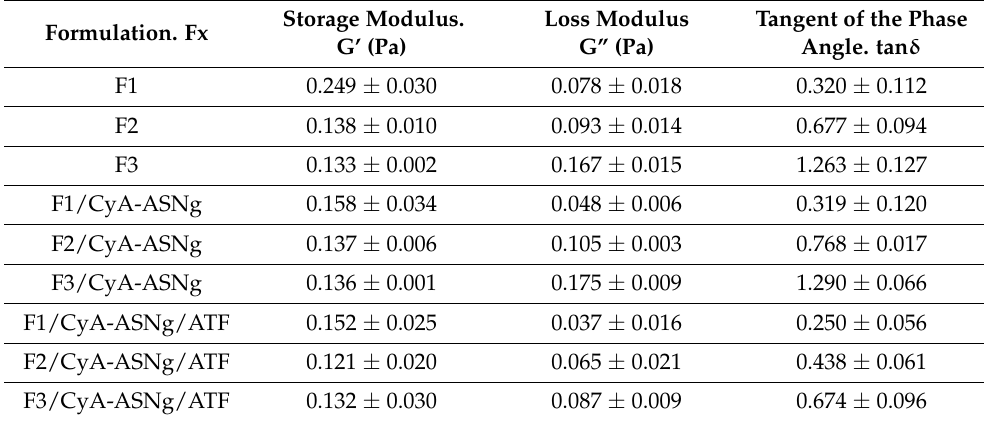
Table 6. Values of G’, G” and tan δ for formulations before and after gelation in the presence of simulated tear fluid of under study formulations (mean ± SD. n = 3).